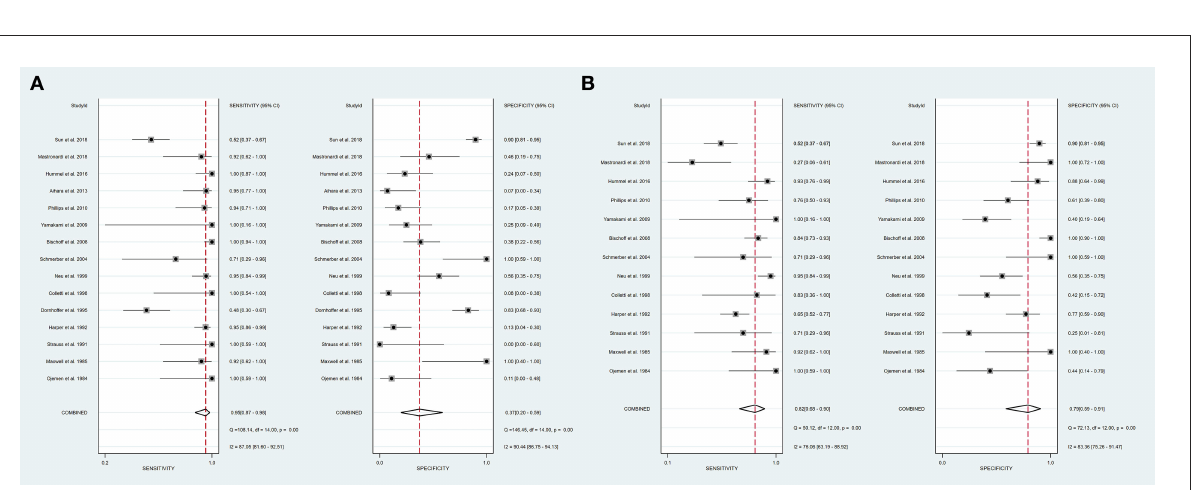
FIGURE3 A forest plot of overall sensitivity and specificity. (A) A forest plot of intraoperative BAEP change group; (B) A forest plot of intraoperative BAEP loss group.